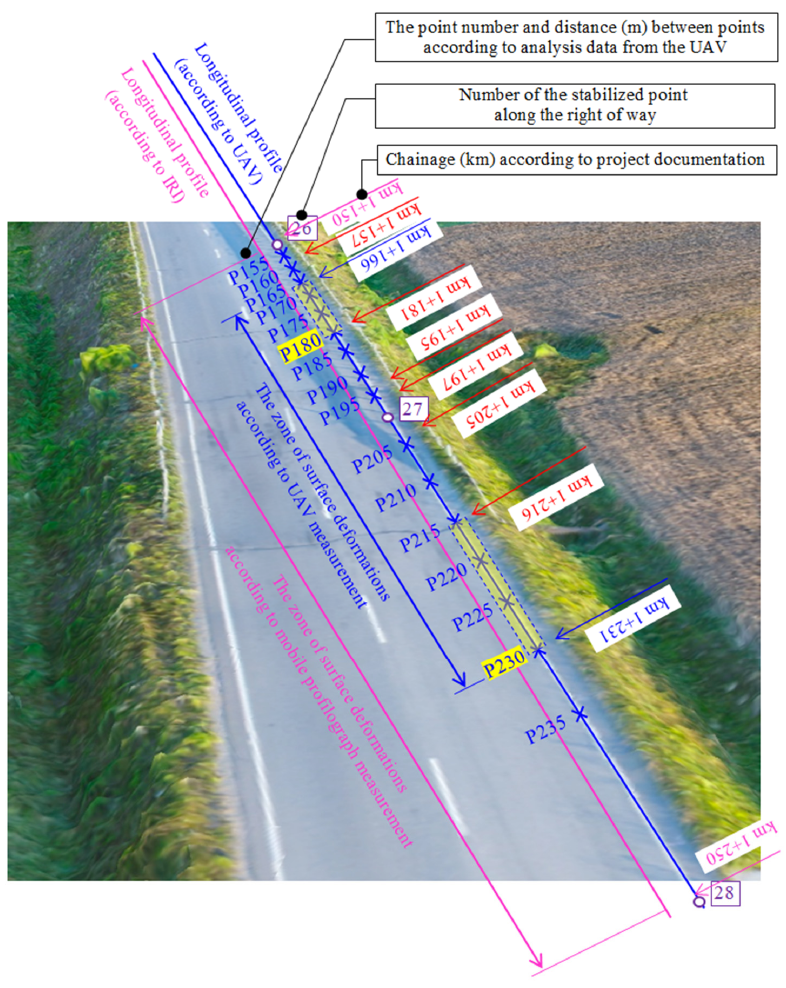
Figure 21. Summary of data analysis results from measurements: UAV and mobile profilograph.